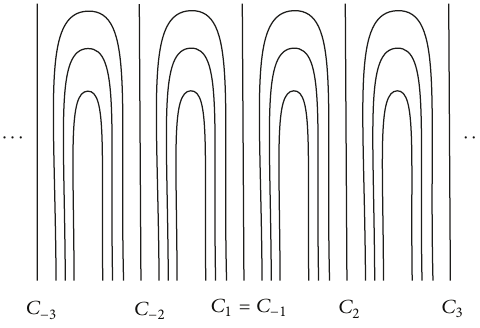
Figure 2: A generalized Reeb flow with 𝐴 − = 𝐴 −∞ and 𝐴 + = 𝐴 +∞